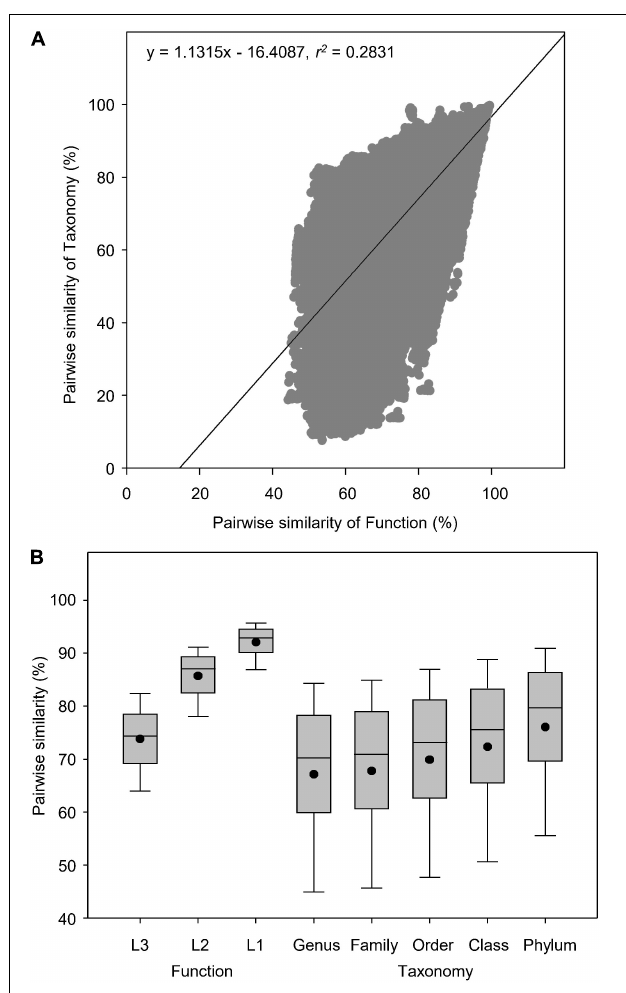
FIGURE 2 | Pairwise similarity of functional and taxonomic diversities. (A) Pearson’s correlations between pairwise Bray-curtis similarity of soil metagenomes annotated in Subsystems database at Level 3 (Function) and RefSeq database at genus level (Taxonomy). (B) Box plots and mean values of pairwise Bray-curtis similarity of soil metagenomes annotated in the SEED Subsystems database, which are composed of subsystems structured into three levels, i.e., the Level 1 is the most general class; the Level 2 is the more general class; the Level 3 is the most specific class (Function) and RefSeq database at genus, family, order, class, and phylum levels